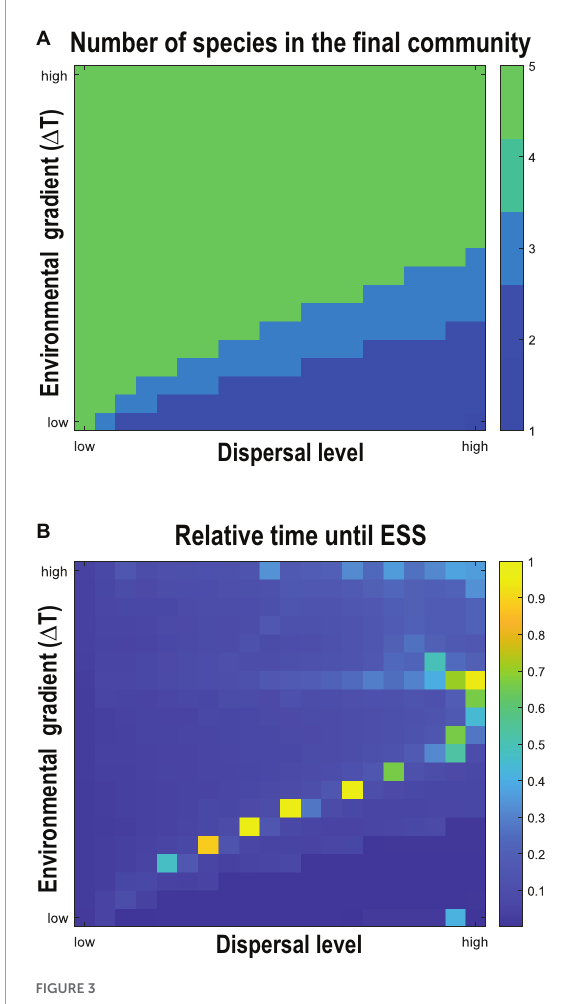
FIGURE3 Simulation outputs across the parameter space of environmental gradient level ( y -axis) and dispersal level ( x -axis) on panel (A) number of species in the final community, and on panel (B) , relative time until the evolutionary stable state. The relative time is calculated as the evolutionary time divided by the longest evolutionary time until the evolutionarily stable state. The range of environmental gradient ( (cid:49) u opt ) is from 0.1 σ u to 1.0 σ u ; The range of dispersal probability is from 10 − 5 to 10 − 1